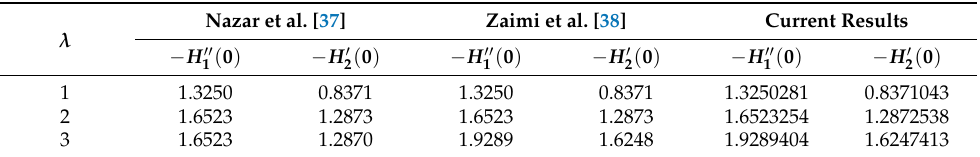
Table 5. The present skin friction coefficient along x -axis and y -axis outcomes validation against λ when other involved parameters are not